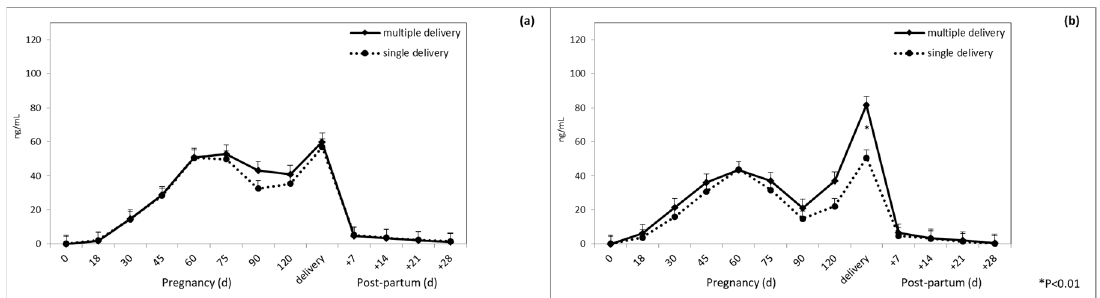
Figure 2. Plasma PAG profile in multiple and single pregnancy at delivery in Sarda ewes when using ( a ) RIA-706 and ( b ) RIA-srPool.